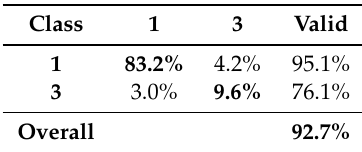
Table 6. Results from the test part of the dataset from the CNN for vehicle classification reduced to 2 classes. Final results for each class on the main diagonal in confusion matrix (highlighted as bold) are shown.